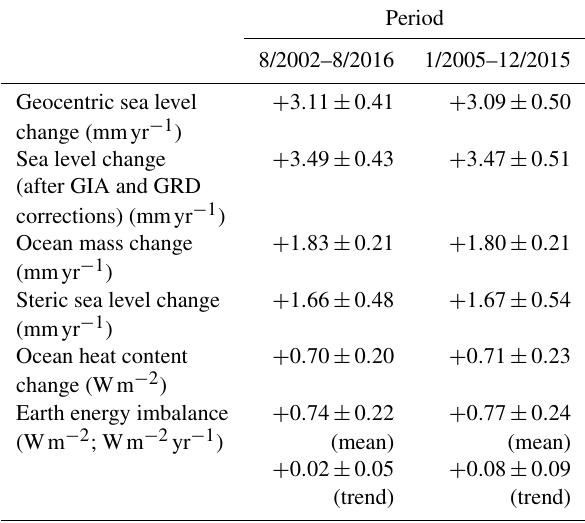
Table C1. Global mean sea level change components, global ocean heat content changes, and Earth energy imbalance – trend and mean values and associated uncertainties as estimated from the various datasets depicted in this paper. Uncertainties are given within a 90%